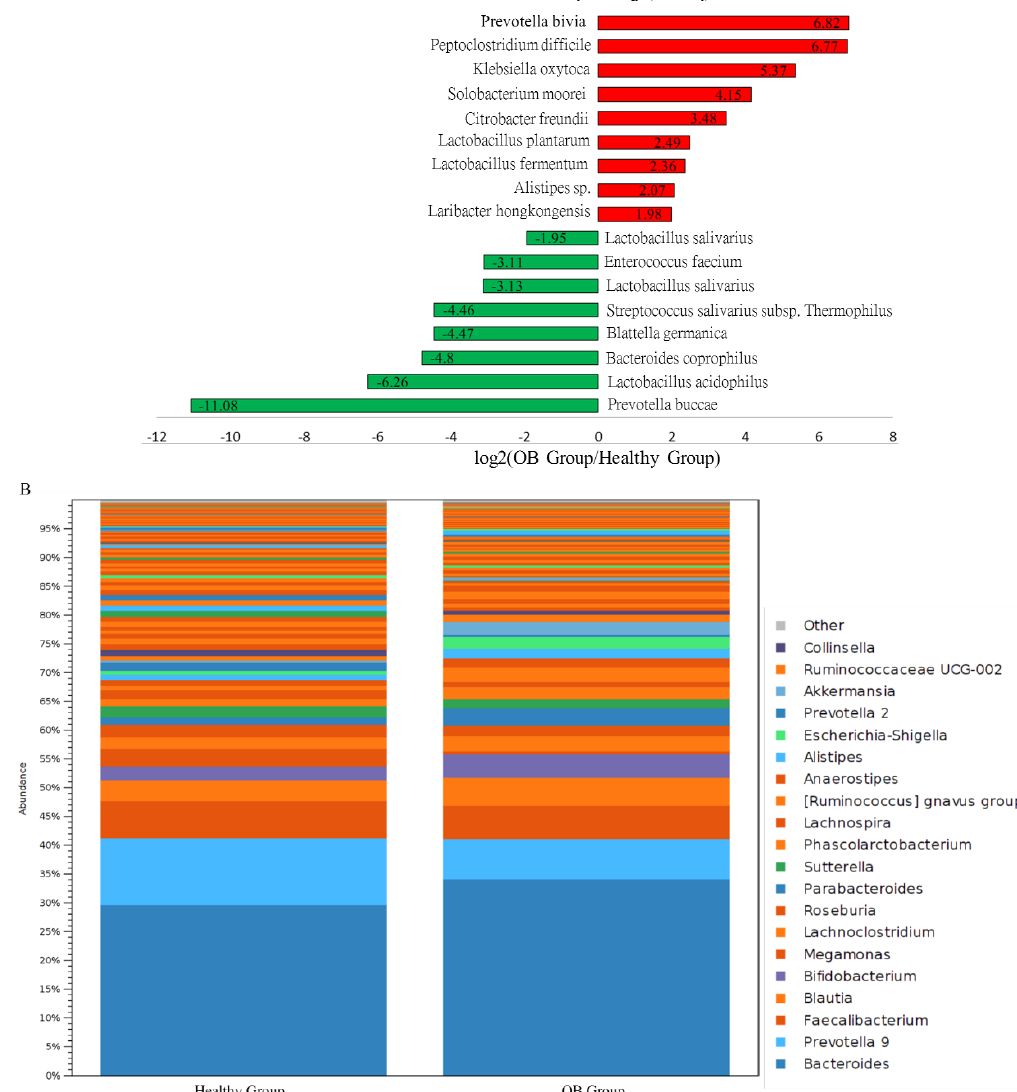
Figure 2. Distinct composition of microbial community of the healthy group and the OB group with short-read sequencing results. ( A ) Increases (red bar) or decreases (green bar) in the differential abundance of identified taxa in OB group as compared to the healthy group. ( B ) The relative abundances of top 20 classified taxa in two groups.